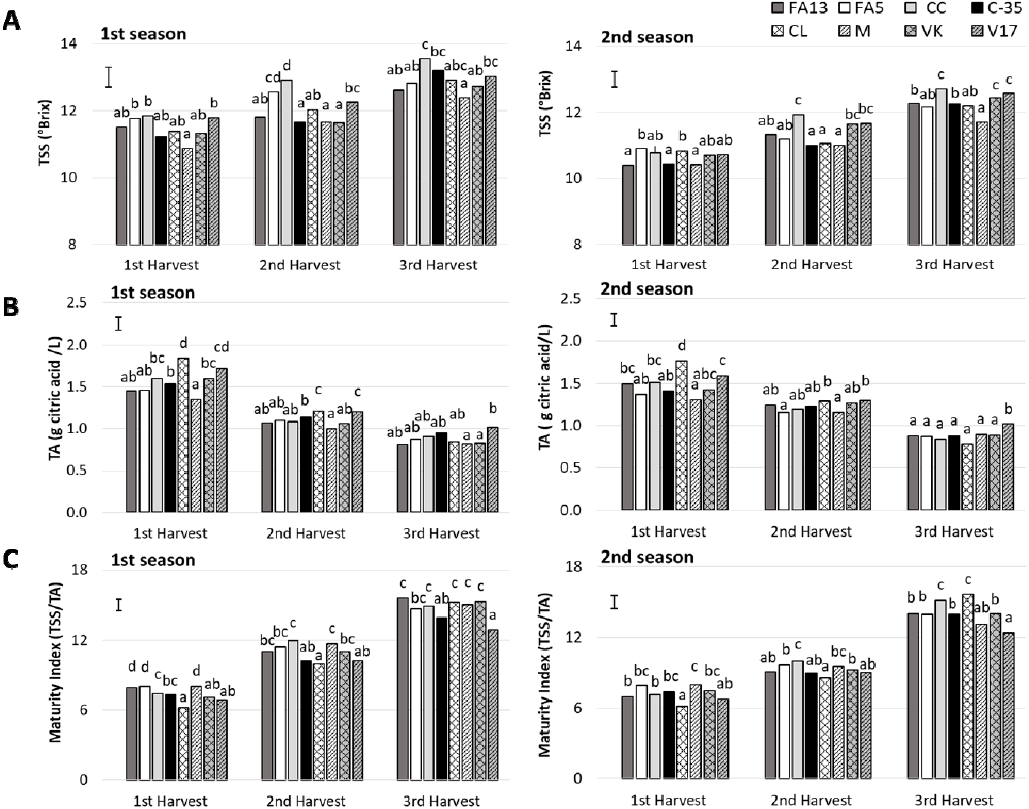
Figure 2. ( A ) Total soluble solids (TSS), ( B ) acidity (TA) and ( C ) Maturity Index (MI) of the ‘Clemenules’ mandarin grafted onto the eight studied rootstocks at three harvest times during two seasons. Vertical bar in each season represents the least significant difference (LSD) intervals ( p ≤ 0.05) (interaction harvest-rootstock). Different letters above bars indicate significant differences among rootstocks at each harvest time ( p ≤ 0.05).